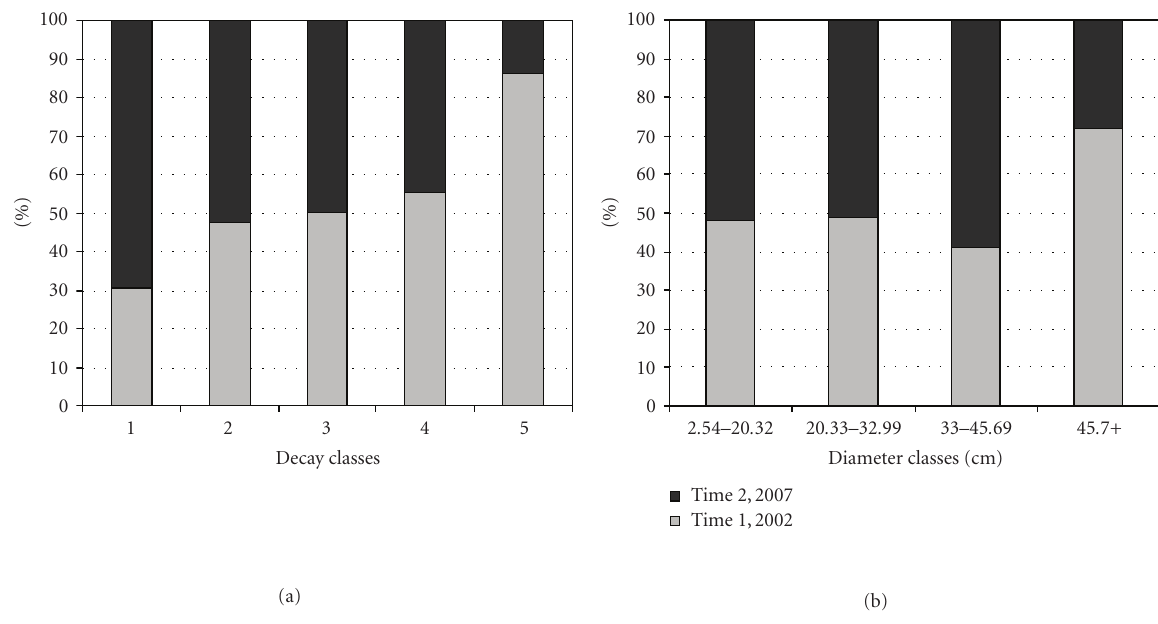
Figure 4: Percentage of coarse woody debris pieces in time one (2002) and time two (2007) in (a) decay classes and (b) transect diameter class in the north central United States, 2002 to 2007.